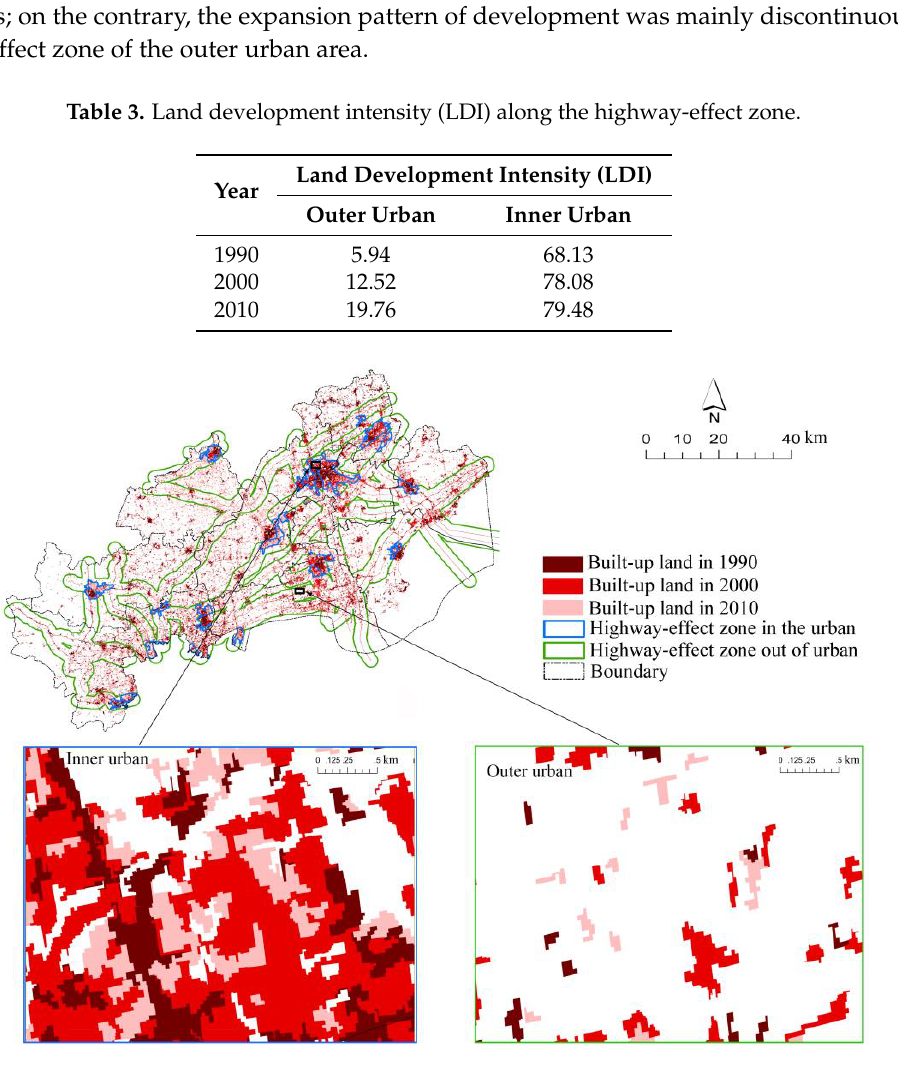
Figure 7. Expansion patterns of the built-up land in the urban and out of urban areas.